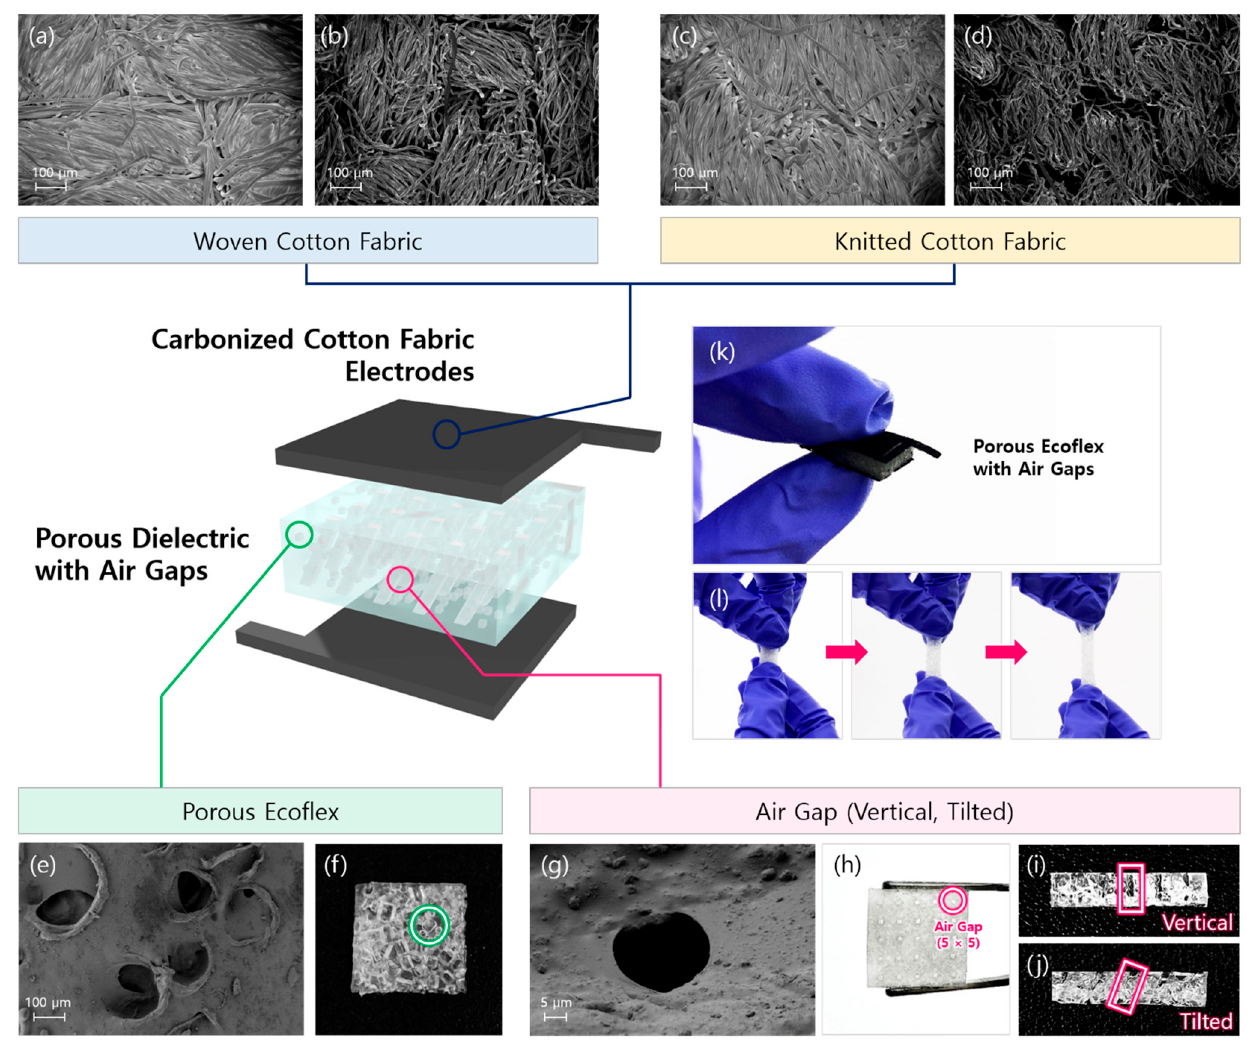
Figure 2. Structure of the CCF-based capacitive pressure sensor and SEM images of the electrodes and dielectric layer. ( a ) Woven pristine cotton fabric; ( b ) woven CCF; ( c ) knitted pristine cotton fabric; ( d ) knitted CCF; ( e ) porous structure of Ecoflex as a dielectric layer; ( f ) top-view image of the porous Ecoflex. The voids inside Ecoflex are the pores created by sugar particles and highlighted in green; ( g , h ) air gaps in the porous dielectric; cross-sectional view images of the vertical ( i ) and tilted air gaps ( j ) in the porous dielectric. The air gaps were formed by metal pins and highlighted in pink; ( k ) real image of the CCF-based capacitive pressure sensor with air gaps; ( l ) high stretchability of the dielectric layer.